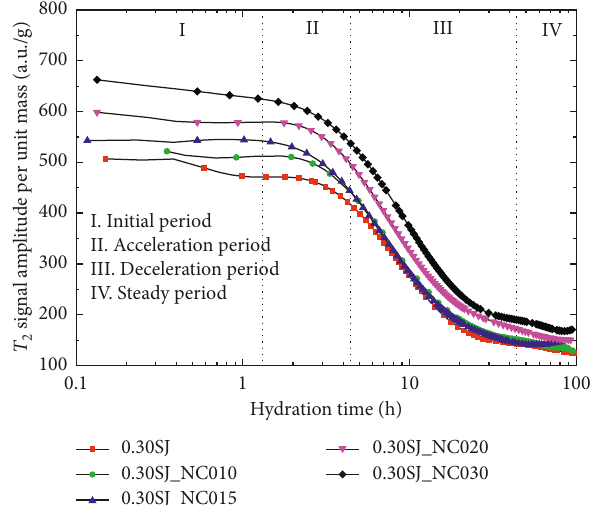
Figure 4: Effects of different w/c on the hydration process. Table 4: The hydration period separation time of pure cement pastes with different w/c.